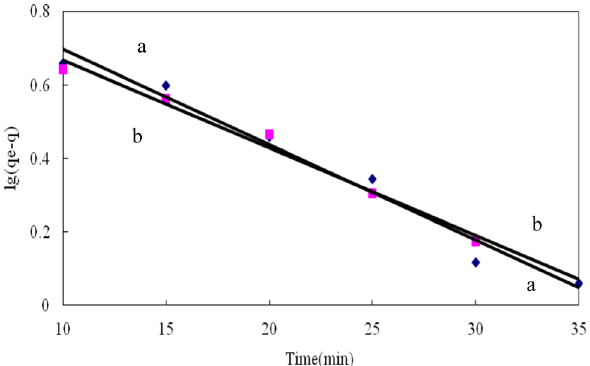
Fig. 1 Pseudo-first-order kinetic simulation; 7.5 g/l of MCM-41, T = 25 °C, pH = 4.5; a Pb 2+ : 1 mg/ml; b Pb 2+ : 4 mg/ml